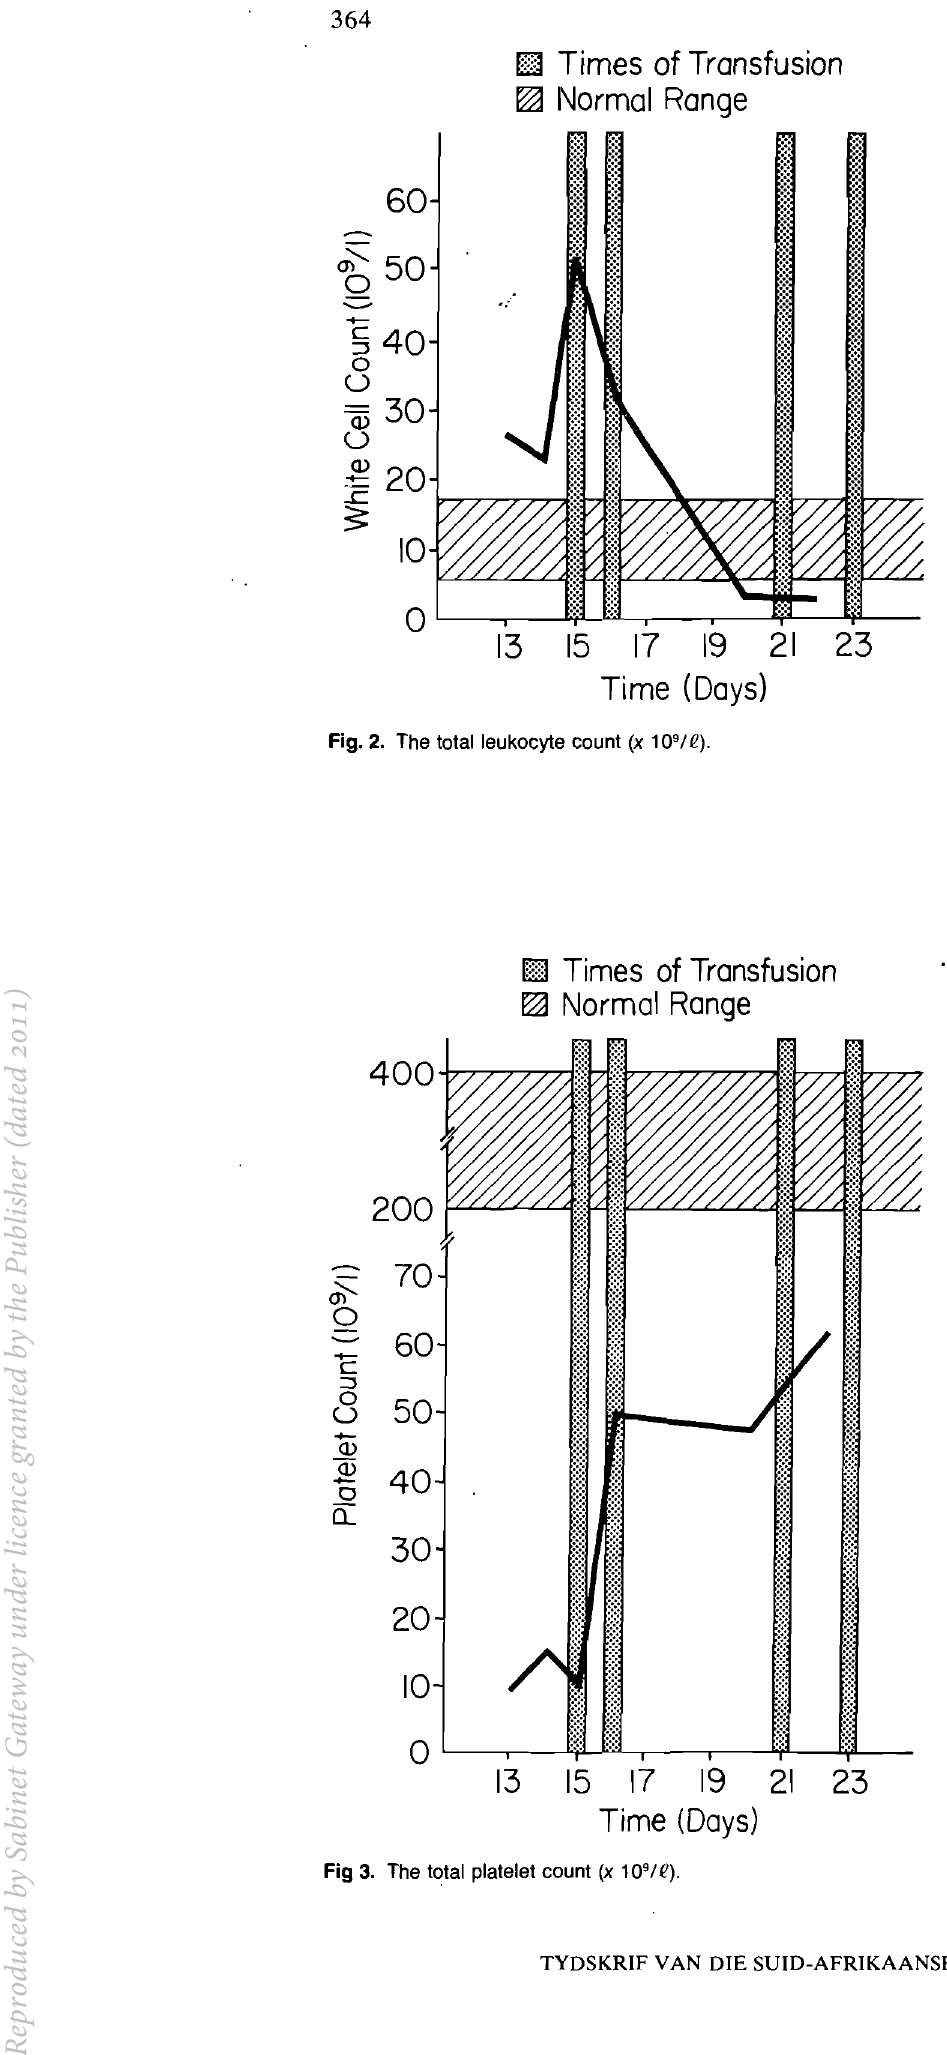
Fig 3. The total platelet count (x 10